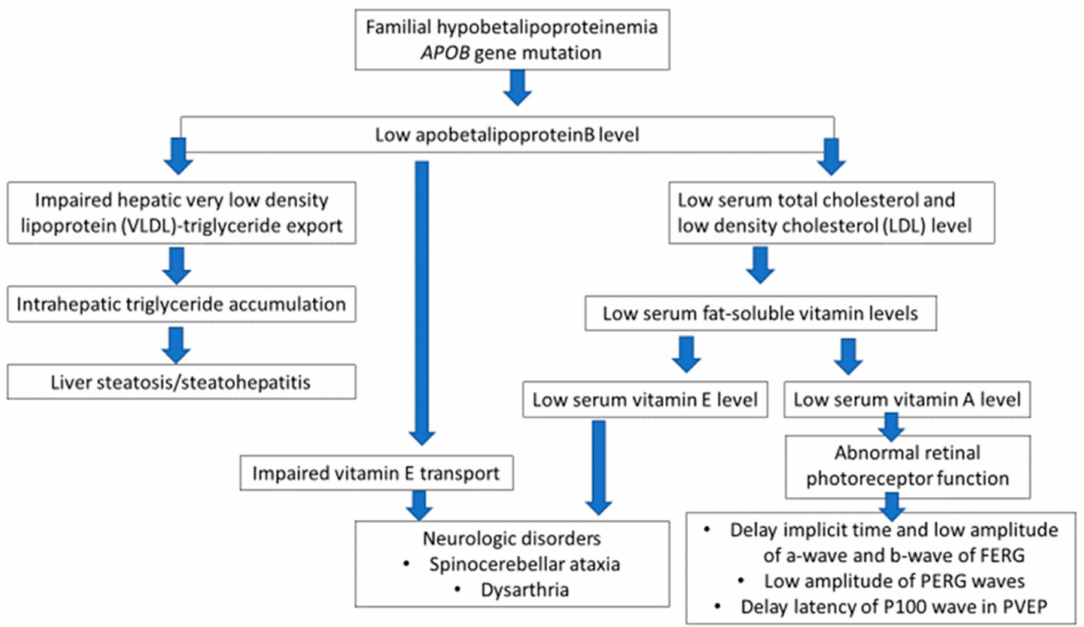
Figure 8. Schematic representation of clinical manifestations in familial hypobetalipoproteinemia (FHBL) as a result of APOB gene mutation (FERG—flash full-field electroretinography; PERG—transient pattern electroretinography; PVEP—transient pattern visual evoked